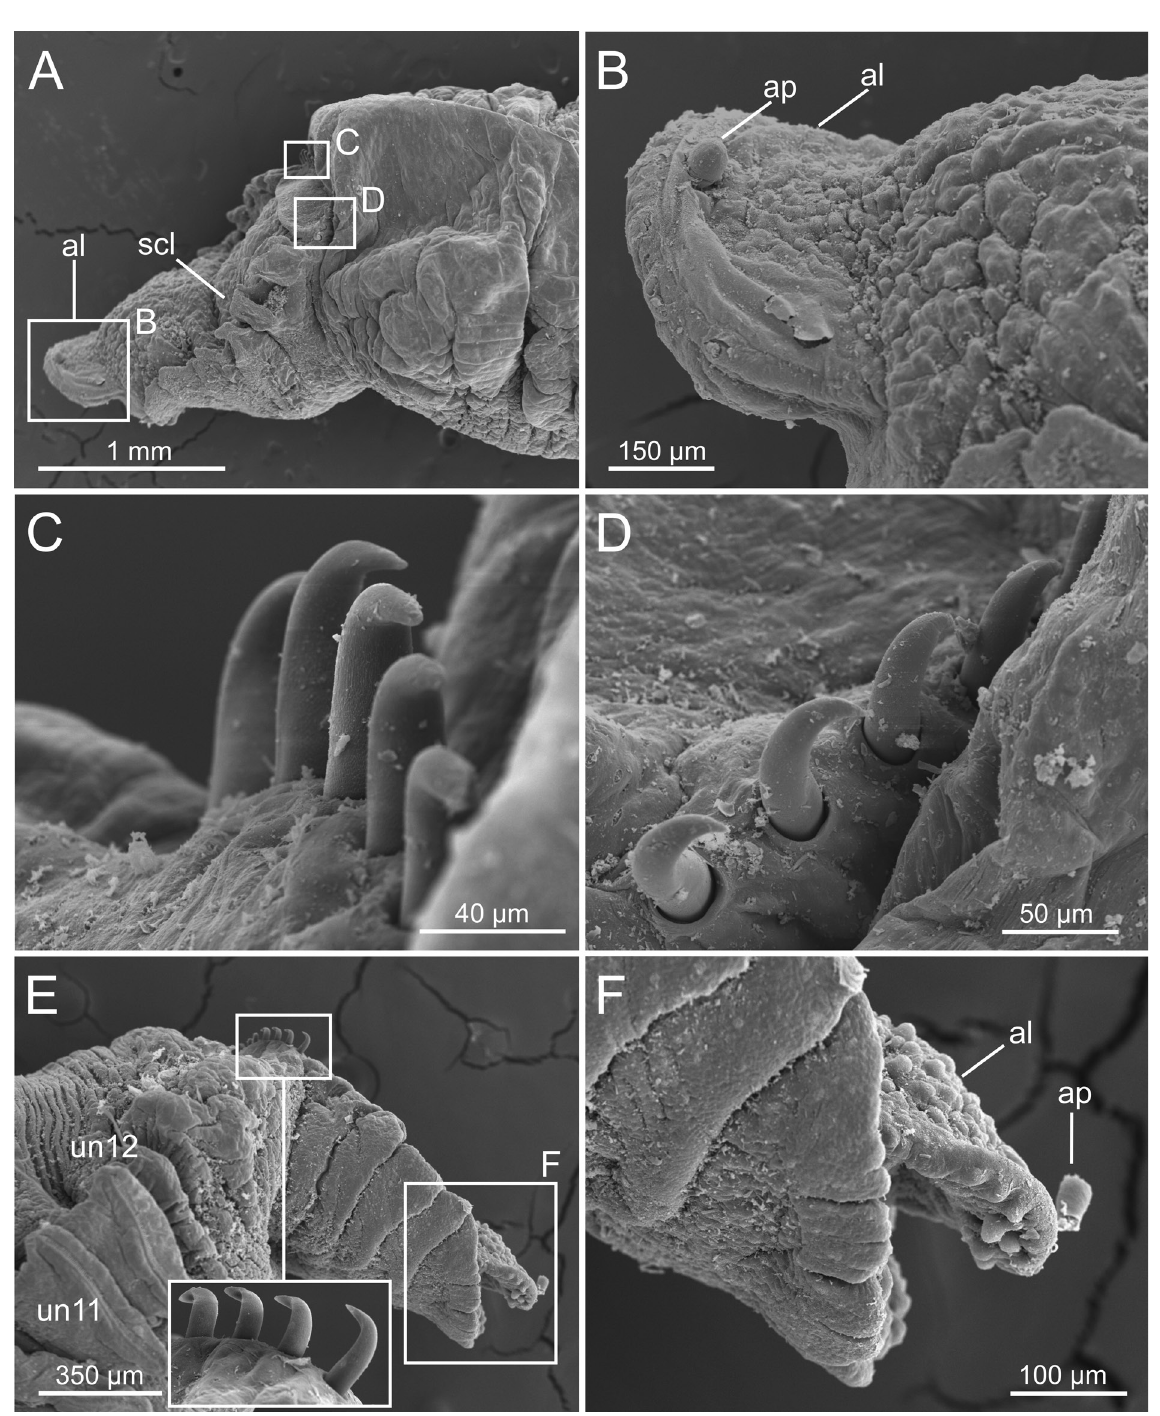
Fig. 11. Cistenides hyperborea Malmgren, 1866. SEM micrographs from four large specimens (A– D: BIOICE sample 3252, IINH-40477; E–F: sample 3249, IINH-40476). A . Scaphe, left lateral view. B . Anal lobe and anal papilla (framed in A). C–D . Scaphal hooks (framed in A). E . Posterior end (framed: scaphal hooks, detail). F . Scaphe and anal lobe and papilla (framed in